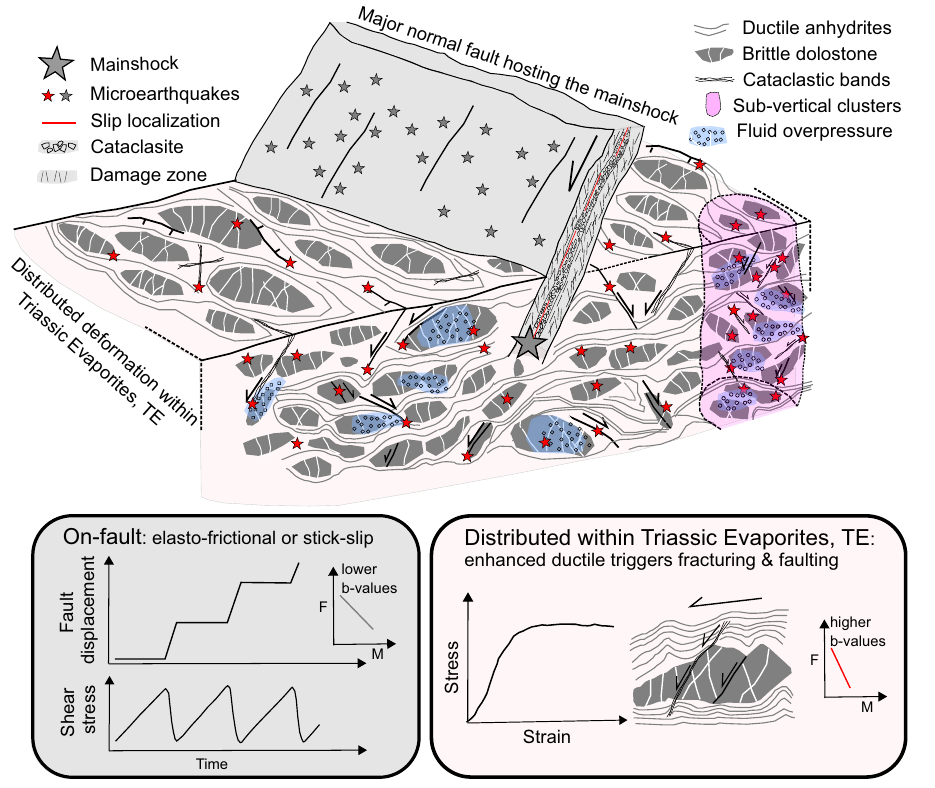
Fig.7|Theroleofrheologyforon-faultvs.distributedseismicity. Cataclasisand slip localization along major normal faults produce fault rocks with frictional properties that promote earthquake nucleation via their stick-slip behaviour. Within the Triassic Evaporites, TE, during the seismic sequence enhanced ductile deformationofthe anhydrites and fl uidoverpressurefavour distributedfracturing